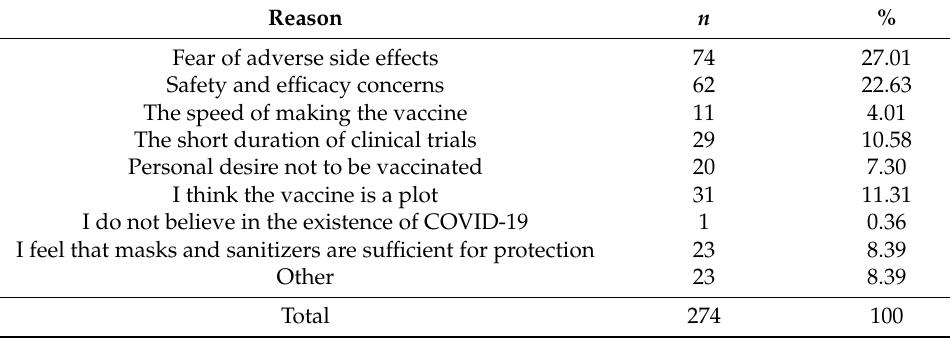
Table 3. Reasons for vaccine hesitancy among older